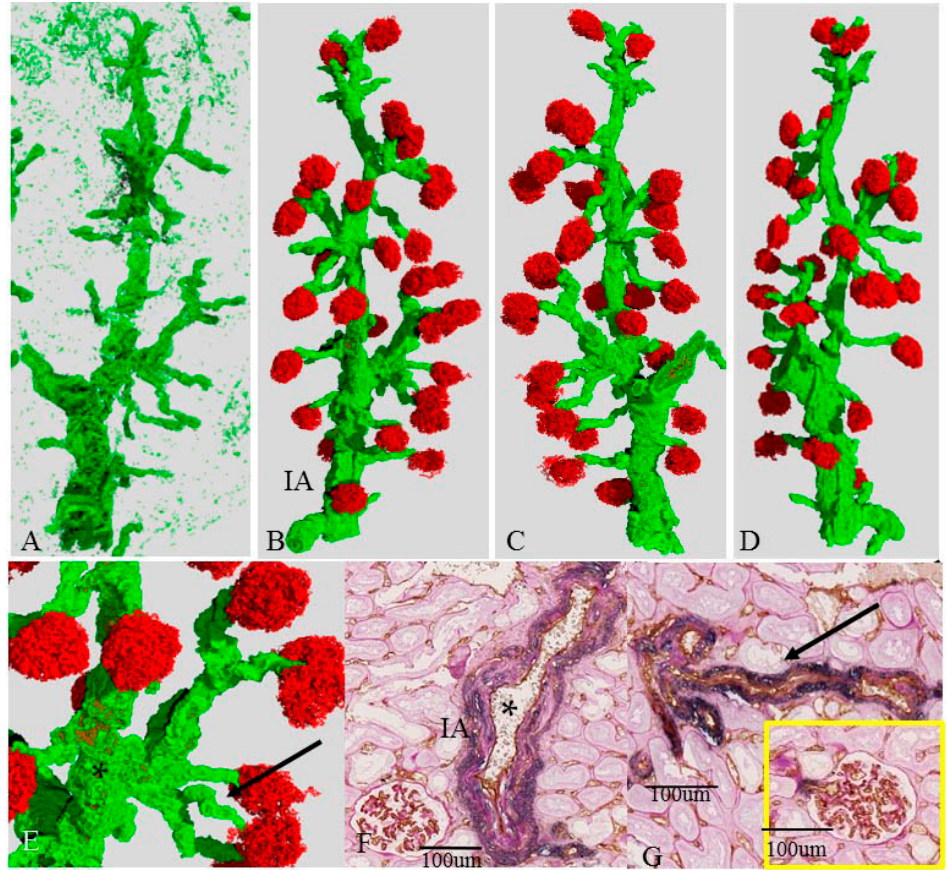
Figure 2. Vascular tree with mild change (Case 2). ( A – E ) single vascular tree with ( B – E ) or without ( A ) associated glomeruli; ( C , D ) rotated images of ( B ); ( E ) magnified view of ( B ). Red and green color correspond to CD34 and SMA in the 2D image, respectively. IA is an interlobular artery ( F , G ) corresponding 2D image that is double-immunostained with anti-CD34 (brown) and anti-SMA (blue) and then periodic acid-Schiff (PAS) stain. The asterisk (*) ( F ) and arrow ( G ) correspond to the same symbols in ( E ); ( A – E ) the interlobular arteries show irregular distribution of SMA and are mildly distorted; ( F ) corresponding 2D view shows that the media ( blue ) is atrophic, and SMA is irregularly distributed; the afferent arterioles are mildly distorted in the 3D view ( A – E ); whereas the corresponding 2D view ( G ) reveals regular media and segmental hyalinosis. The yellow circle represents a glomerulus supplied by this afferent arteriole.